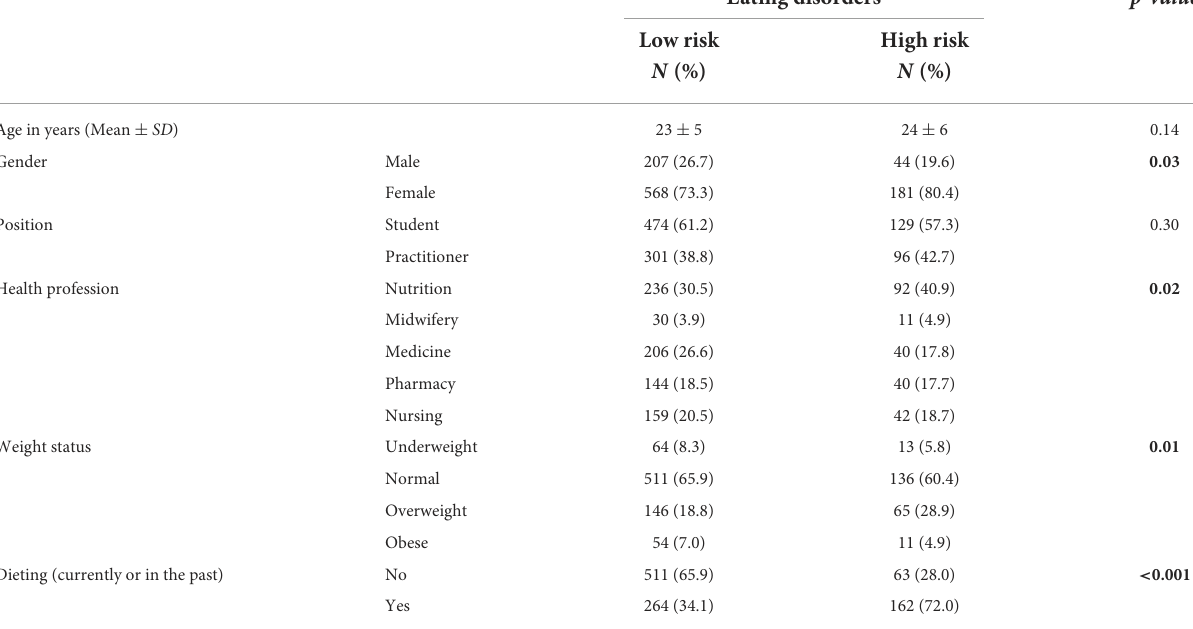
TABLE 2 The correlates for the risk of eating disorders.